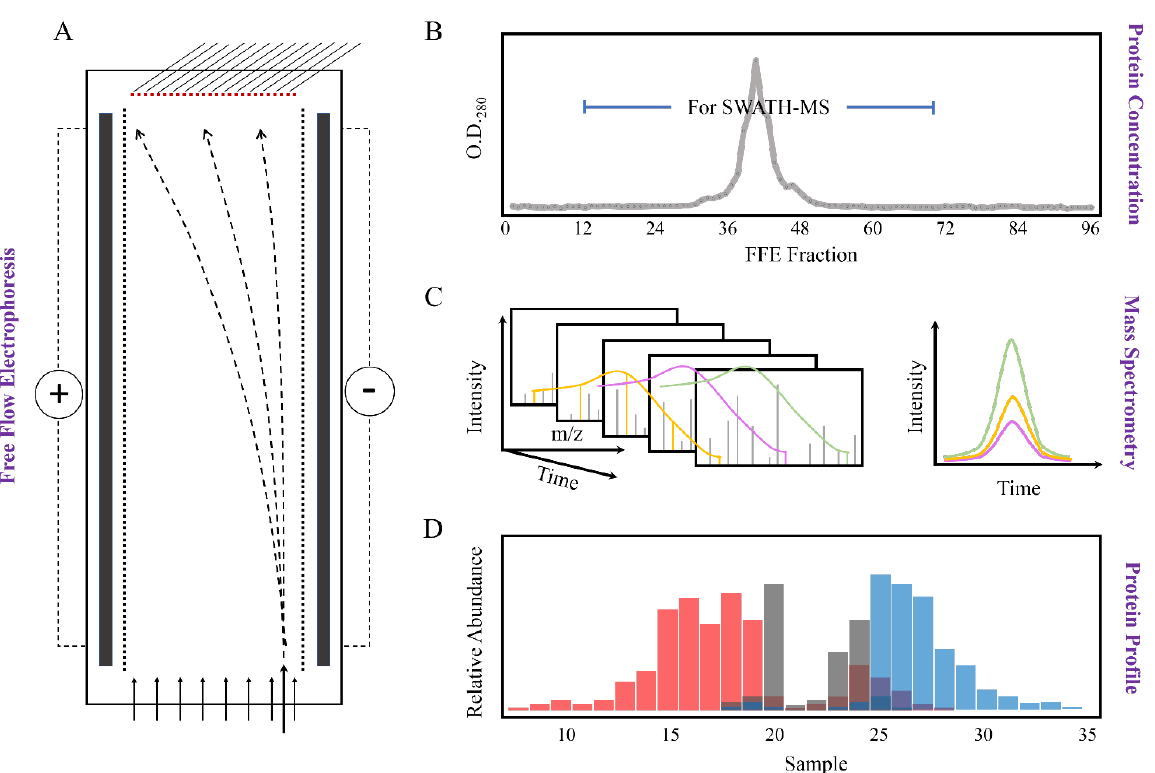
Figure 2. Schematic overview of sample fractionation by Free Flow Electrophoresis (FFE) and downstream analysis by mass spectrometry. ( A ) Microsomal membranes from M. crystallinum leaf tissue were fractionated by FFE into 96 fractions based on their different net surface charge; ( B ) The absorbance of FFE fractions was determined at 280 nm to identify the range of fractions with positive protein values. Fractions 15 to 70 with positive protein values at O.D. 280 were used for subsequent protein identification; ( C ) Proteins were analyzed by SCIEX TripleTOF 6600 in IDA and SWATH-MS modes for reference library generation, protein identification, and quantification; ( D ) The average protein abundance of three biological replicates of each sample was used for the “digital western” FFE profile generation. Here we use the term digital western to refer to the detection of proteins by MS/MS in specific FFE fractions, similar to a traditional Western where proteins in the wells of a gel are detected by antibodies. Different colored columns indicate different subcellular membrane origins based on marker protein profiles.